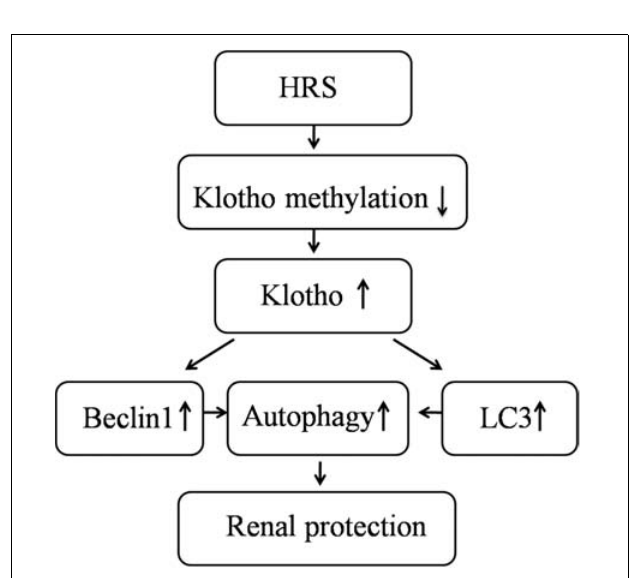
FIGURE 4 | Schematic illustration of the molecular mechanisms of HRS-induced renoprotection against AKI to CKD after IR.